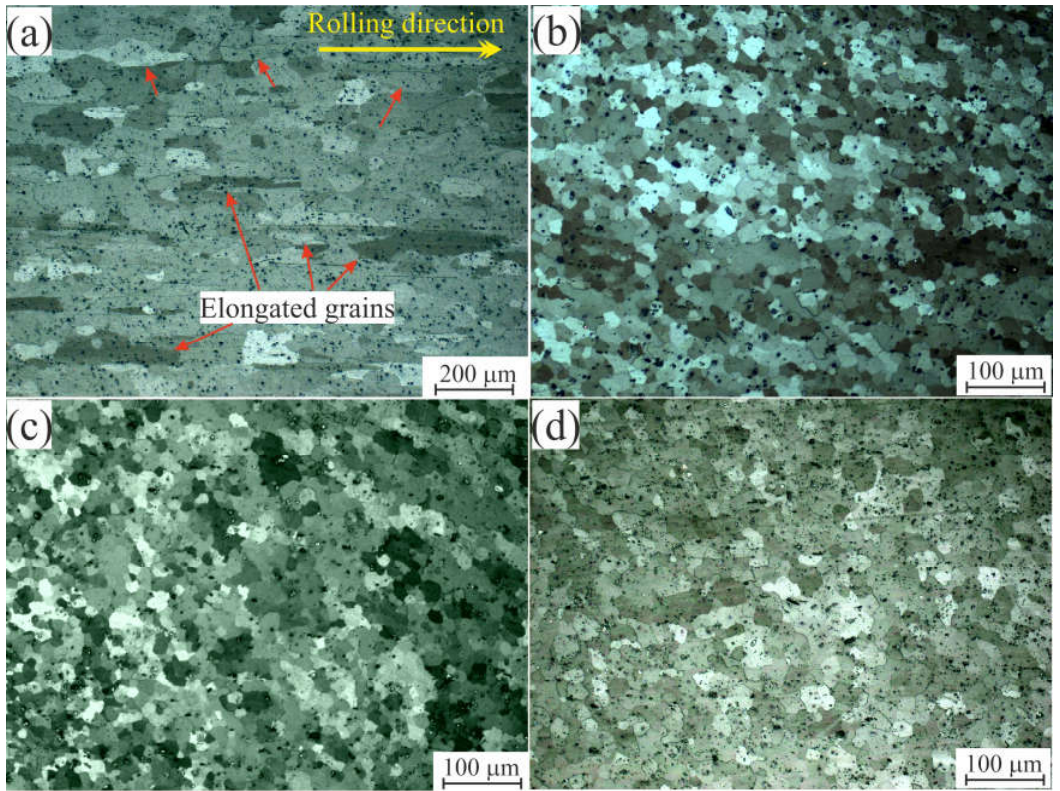
Figure 2. Optical microscope micrographs of (a) as-rolled plates (base metal), (b) composite with mono-reinforcement (VC), (c) composite with the hybrid-reinforcements (VC + BN), and (d) composites with triple-reinforcements (VC + BN + GNPs).